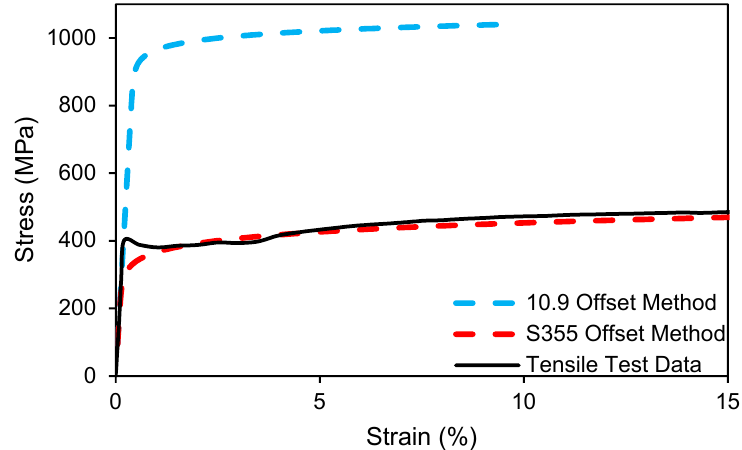
Figure 1. Stress-strain curves obtained using the offset method.